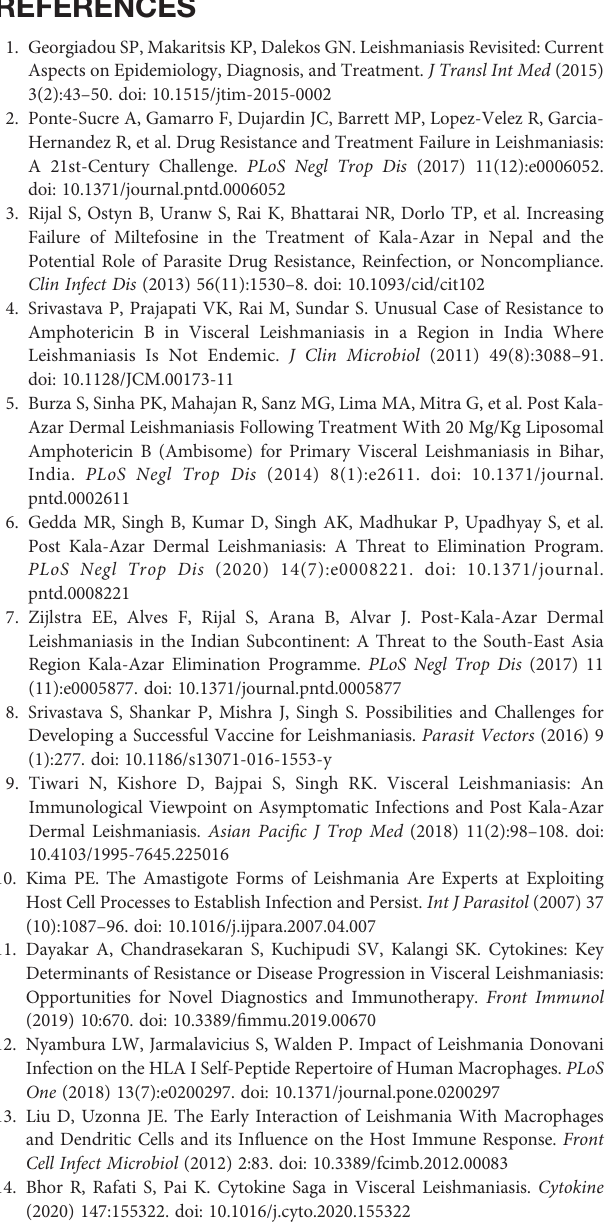
Supplementary Figure 1 | The numbers of amastigotes per 100 macrophages (A) and BMDCs (B). The infected cells were incubated up to 48h